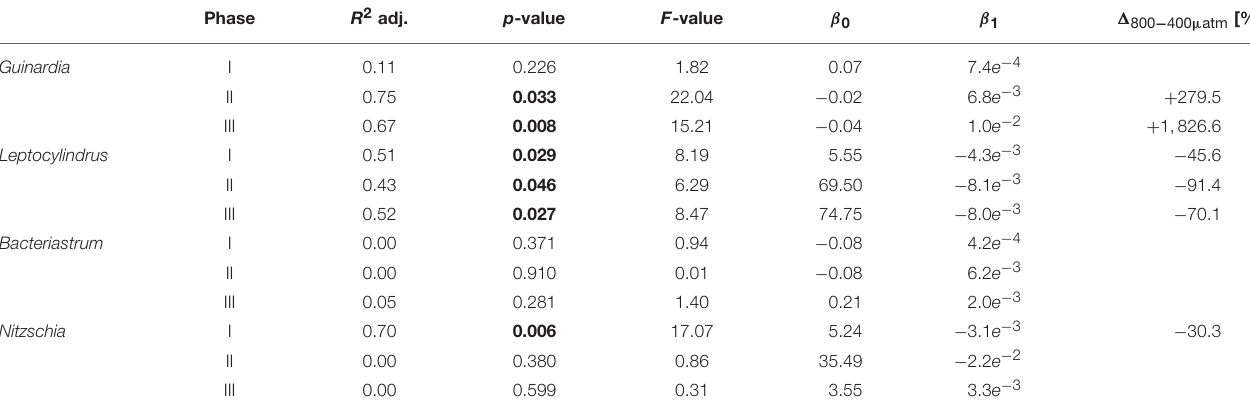
TABLE 4 | Results of linear regression for CO 2 effects on diatom species counted by light microscopy. Phase R 2 adj. p -value F -value β